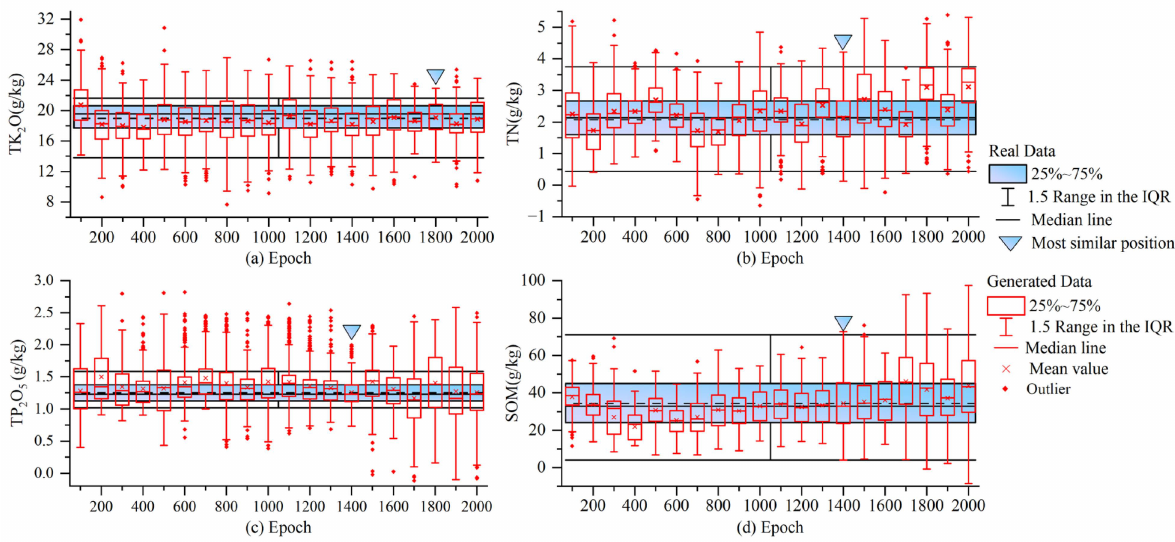
Figure 7. Boxplot of TK 2 O, TN, TP 2 O 5 , and SOM data generated by GAN and real data. a, b, c, and d in the figure are boxplots of TK 2 O, TN, TP 2 O 5 , and SOM data generated by GAN at different epochs with the real data. When the generated data is closest to the real data, the data is considered to be the